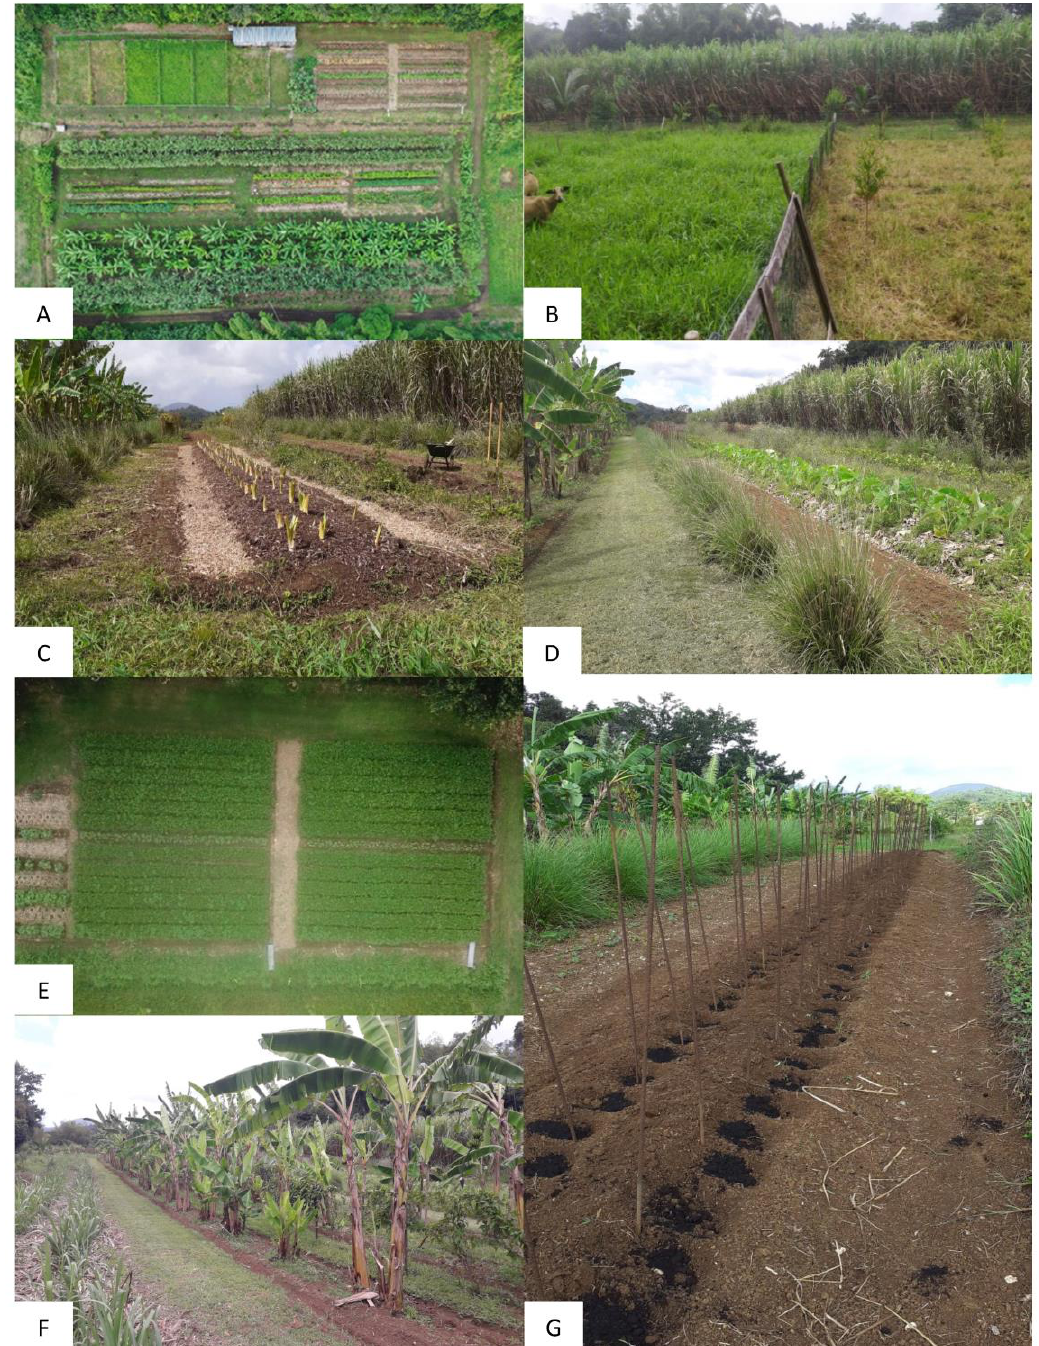
Figure 3. Aerial photographs of the AEMF. ( A ) The overview of the AEMF corresponds to the structure is presented in Figure 2. ( B ) The rotating pasture with on the right a unit after 7 days of grazing and on the left the sheep grazing on the next unit. ( C ) The tuber activity just after the plantation of Xanthosoma sagittifolium . ( D ) X. sagittifolium a few weeks after plantation. ( E ) Aerial photograph of the market gardening activity showing a high-density legumes plantation. ( F ) Photographs were taken between the banana and the sugarcane (a few weeks after harvesting) activities on the right and the left, respectively. Between both, an example of a permanent pathway is seen. ( G ) The tuber activity just before Dioscorea spp. plantation is an example of compost amendment. On the left, we can see Chrysopogon zizanioides, and on the right, a part of the permanent strip flower.